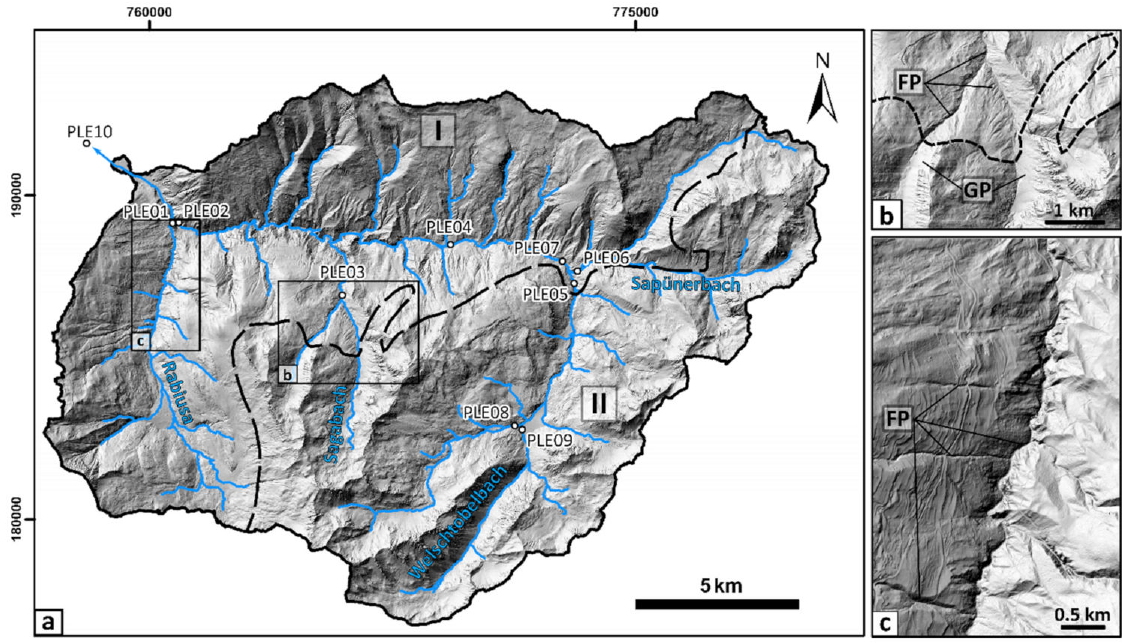
Figure 9. ( a ) Identification of fluvial patterns (FP) and glacial pattern (GP) in a digital elevation model of the Plessur Basin. The dashed line marks the division between lithologies with high and low erodibilities, and it separates the downstream sector I of the basin, which is dominated by fluvial processes and highly dissected, from the upstream sector II, which preserves glacial patterns, displayed by a smoother landscape. ( b ) Details of the Sagabach drainage area displaying the contrasts between the rougher fluvially controlled landscape (FP) and the topography that has still preserved features related to glacial erosion (GP). ( c ) Details of the Rabiusa drainage area showing landscape patterns indicative for fluvial erosion (FP) and associated hillslope erosion. The numbers at the border of the figure indicate the Swiss coordinates in